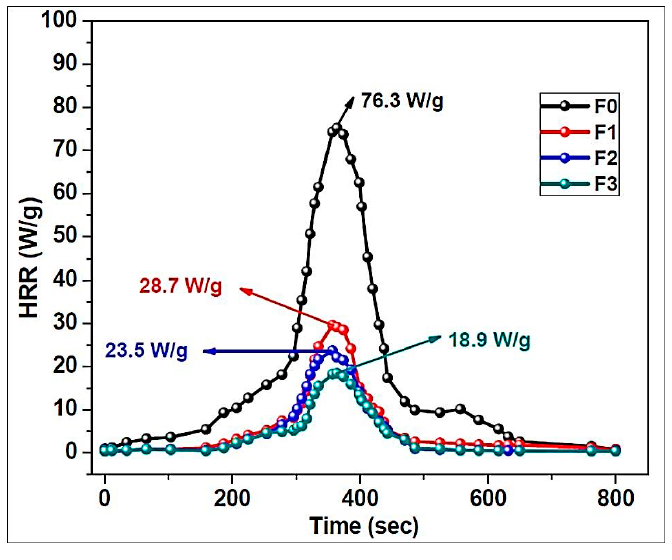
Figure 9. Peak heat release rate curves of the flame retardant samples.